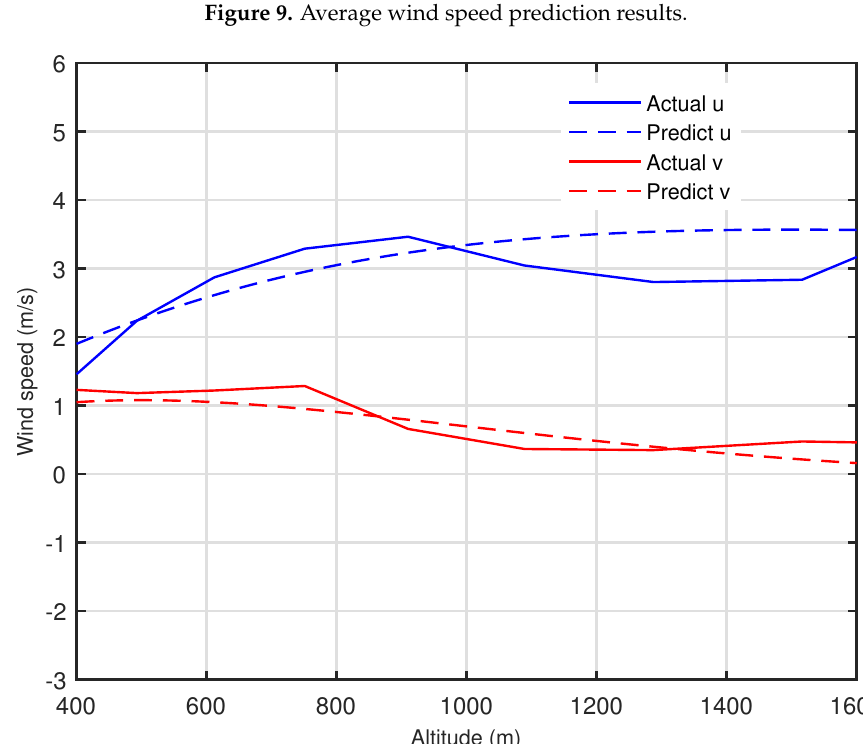
Figure 10. Comparison results of actual wind and predicted